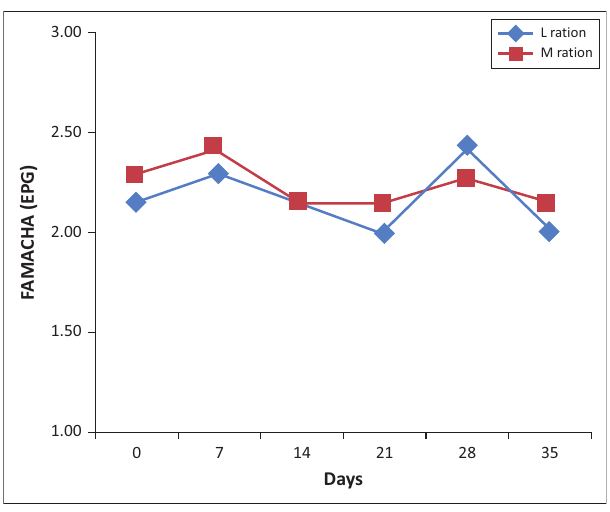
FIGURE 3: The effect of feeding a Lespedeza cuneata or Medicago sativa hay ration on the mean FAMACHA © scores of parasitised